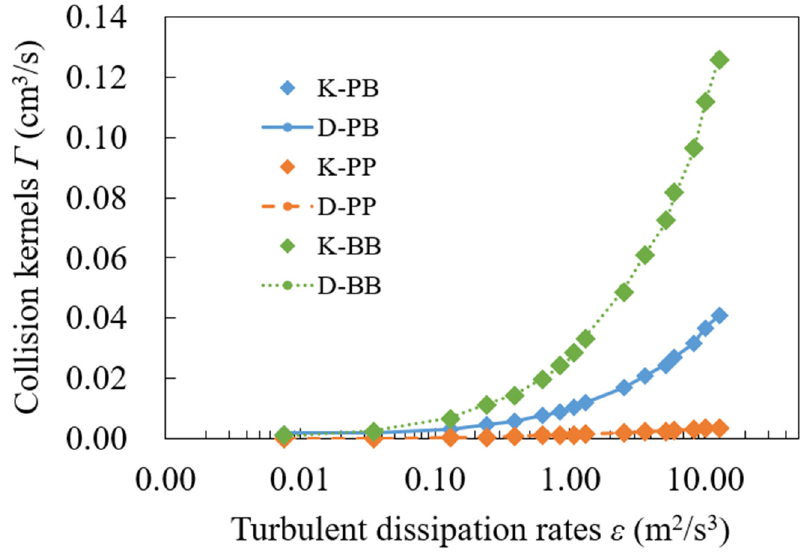
Figure 2. The collision kernels as a function of the turbulent energy dissipation rate [39]. Particles and bubbles were considered to be point particles in the above simulations.